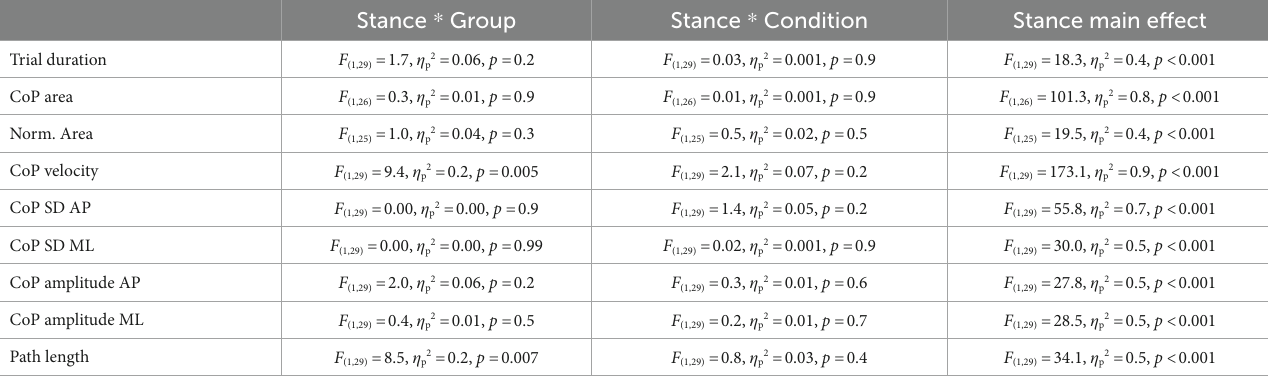
TABLE 3 Statistical interactions and main effects for CoP parameters. Stance * Group Stance * Condition Stance main